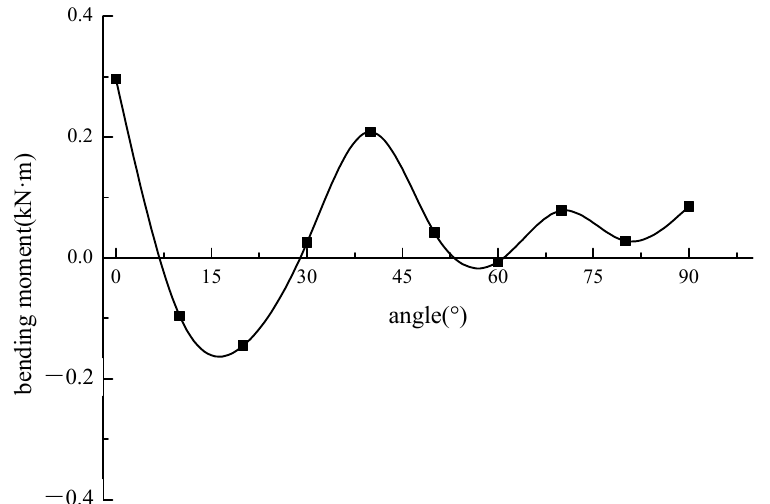
Figure 5. Structure bending moment under optimized adjustment load.